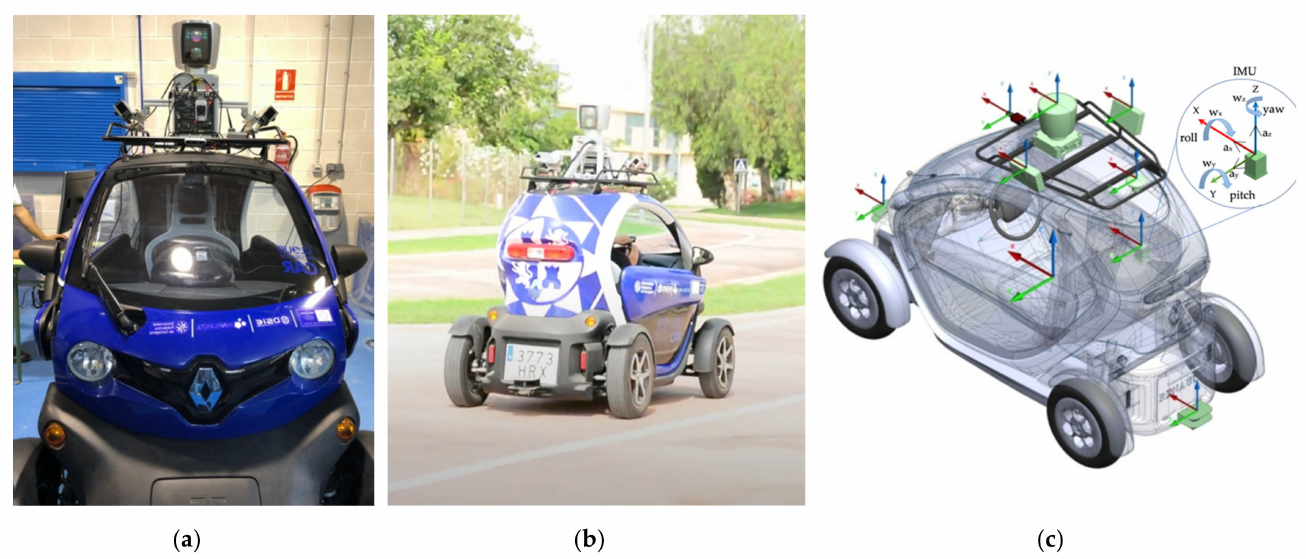
Figure 2. ( a ) Cloud Incubator Car autonomous vehicle (CiCar). ( b ) CiCar on data acquisition mission. ( c ) Vehicle model and IMU sensor measurement details.